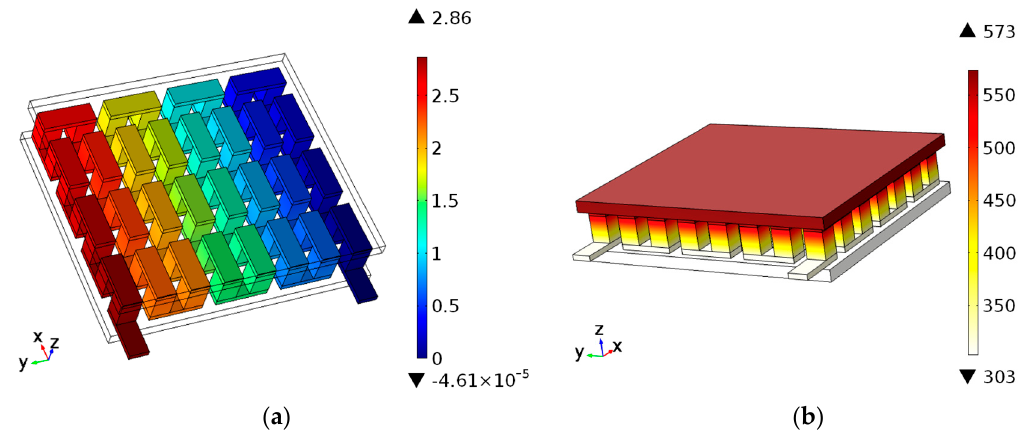
Figure 3. Results of the open circuit simulation using the model containing 28 thermoelectric pairs, with T c = 30 °C and T h = 300 °C: ( a ) open circuit voltage (V); ( b ) temperature gradient (K) in the device.